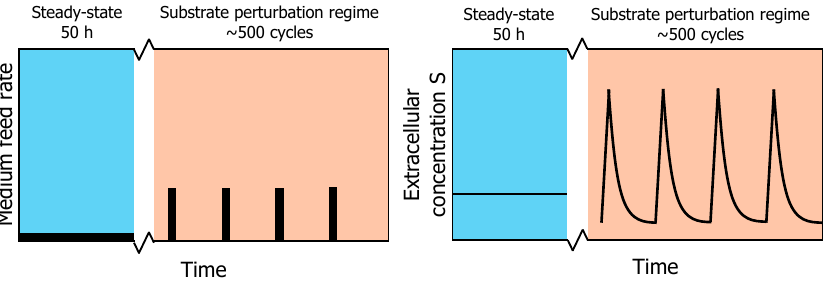
Figure 1. Profile of the experimental feeding regime. After a chemostat phase (reference steady-state) of 50 h, a block-wise feed is applied in a 400 s cycle at the same average substrate supply and dilution rate for another 50 h (adapted from [13]). On the left, a schematic overview of the feed rate during chemostat and repeated substrate perturbation regimes is shown. On the right, the resulting extracellular substrate concentration profile in the fermentation broth is